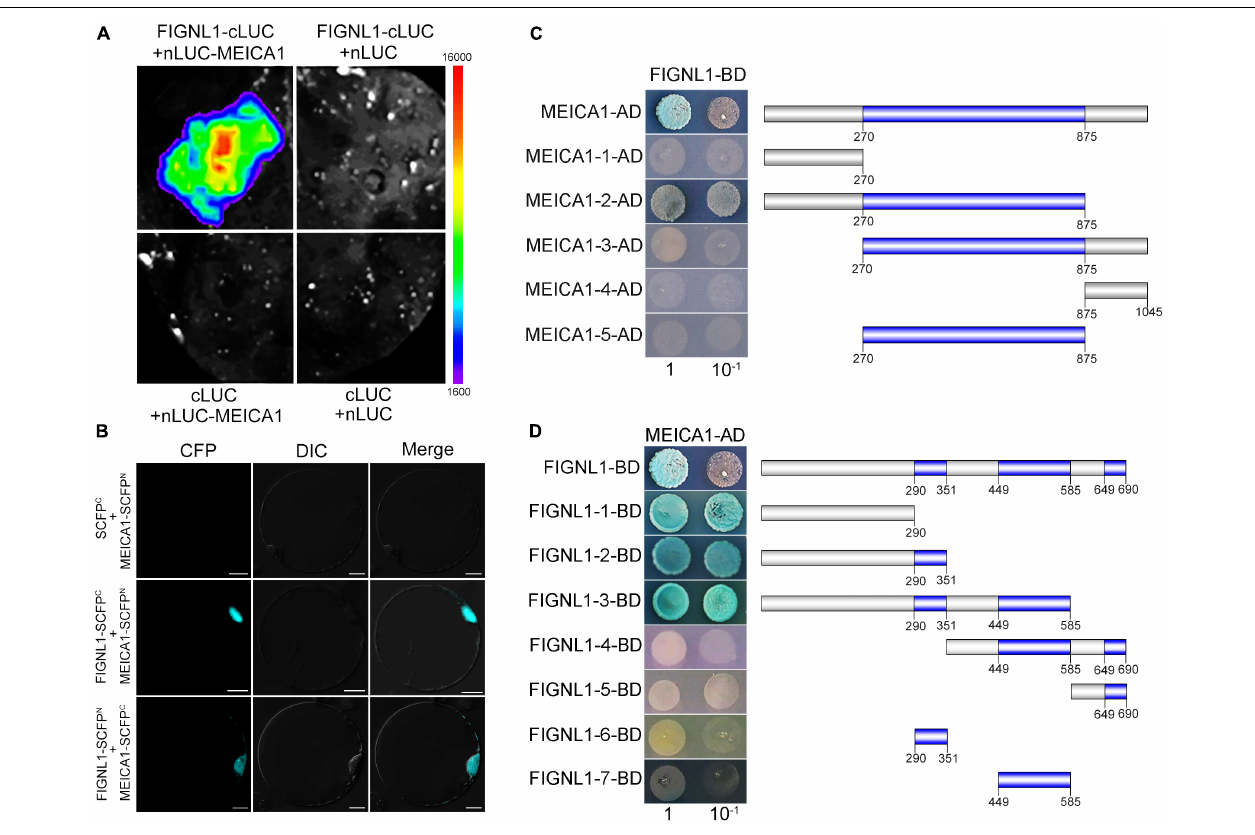
FIGURE 8 | The region responsible for the interaction between FIGNL1 and MEICA1 is conserved. (A) FIGNL1 interacts with MEICA1 in LUC assays. (B) FIGNL1 interacts with MEICA1 in BiFC assays. (C) The region of MEICA1 responsible for the interaction between FIGNL1 and MEICA1. (D) The region of FIGNL1 responsible for the interaction between FIGNL1 and